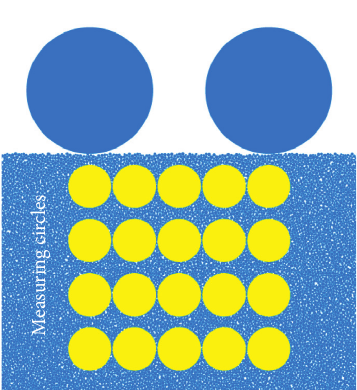
Figure 7: Layout of measuring